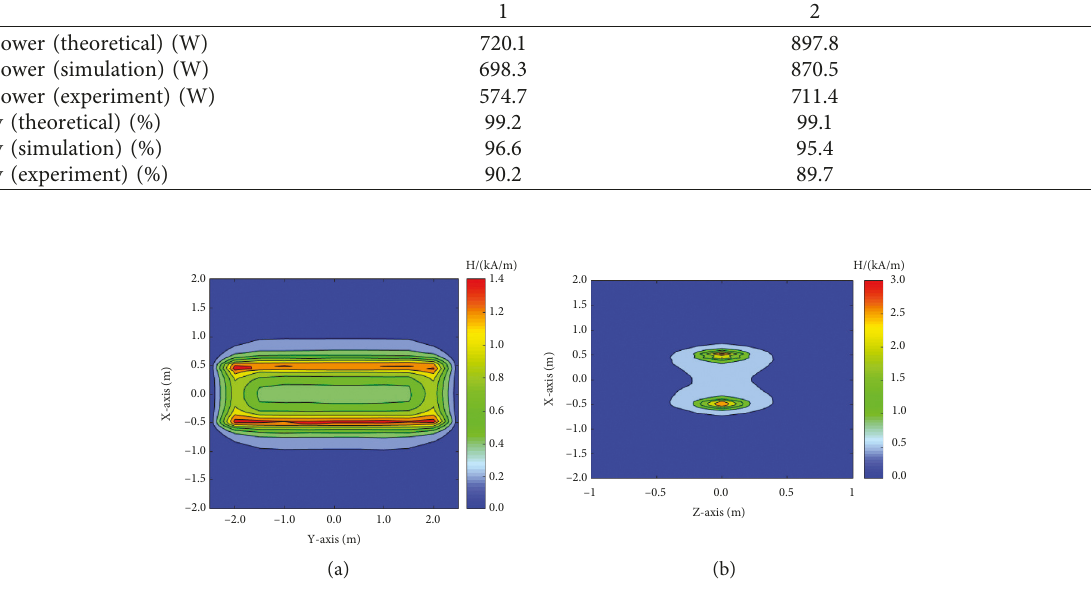
Figure 15: Magnetic field strength of coupling coil. (a) The distribution of magnetic field strength in the XY plane. (b) The distribution of magnetic field strength in the XZ